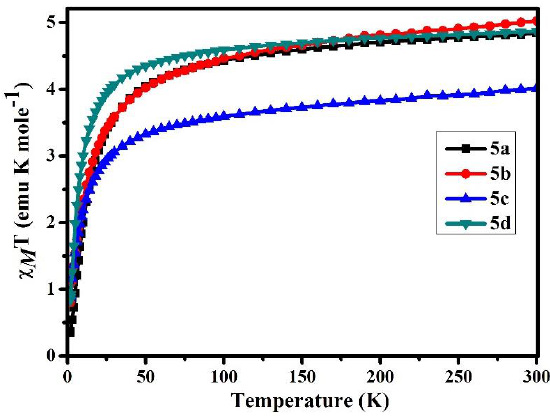
Figure 4. χ M T versus T plot for all B-L MILs at 1.0 kOe. Table 4. Comparison of magnetic susceptibility and Weiss constant (fit with Curie–Weiss formula) between B-L MILs and previously reported [FeCl4] − salts ( χ M T: magnetic susceptibility, µ eff : spin-only effective magnetic susceptibility, Θ : Weiss constant).